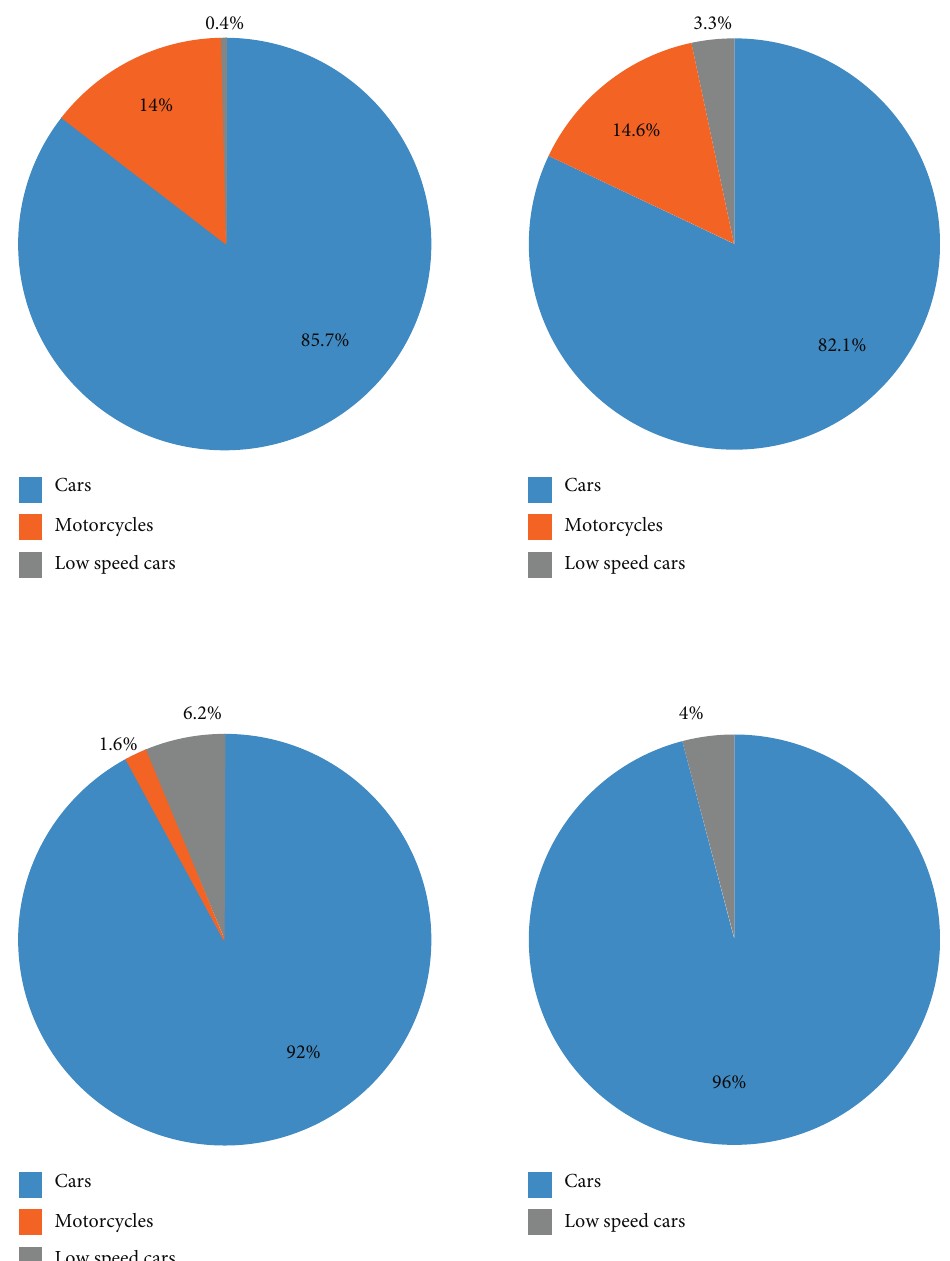
Figure 1: Motor vehicle pollutant discharge.